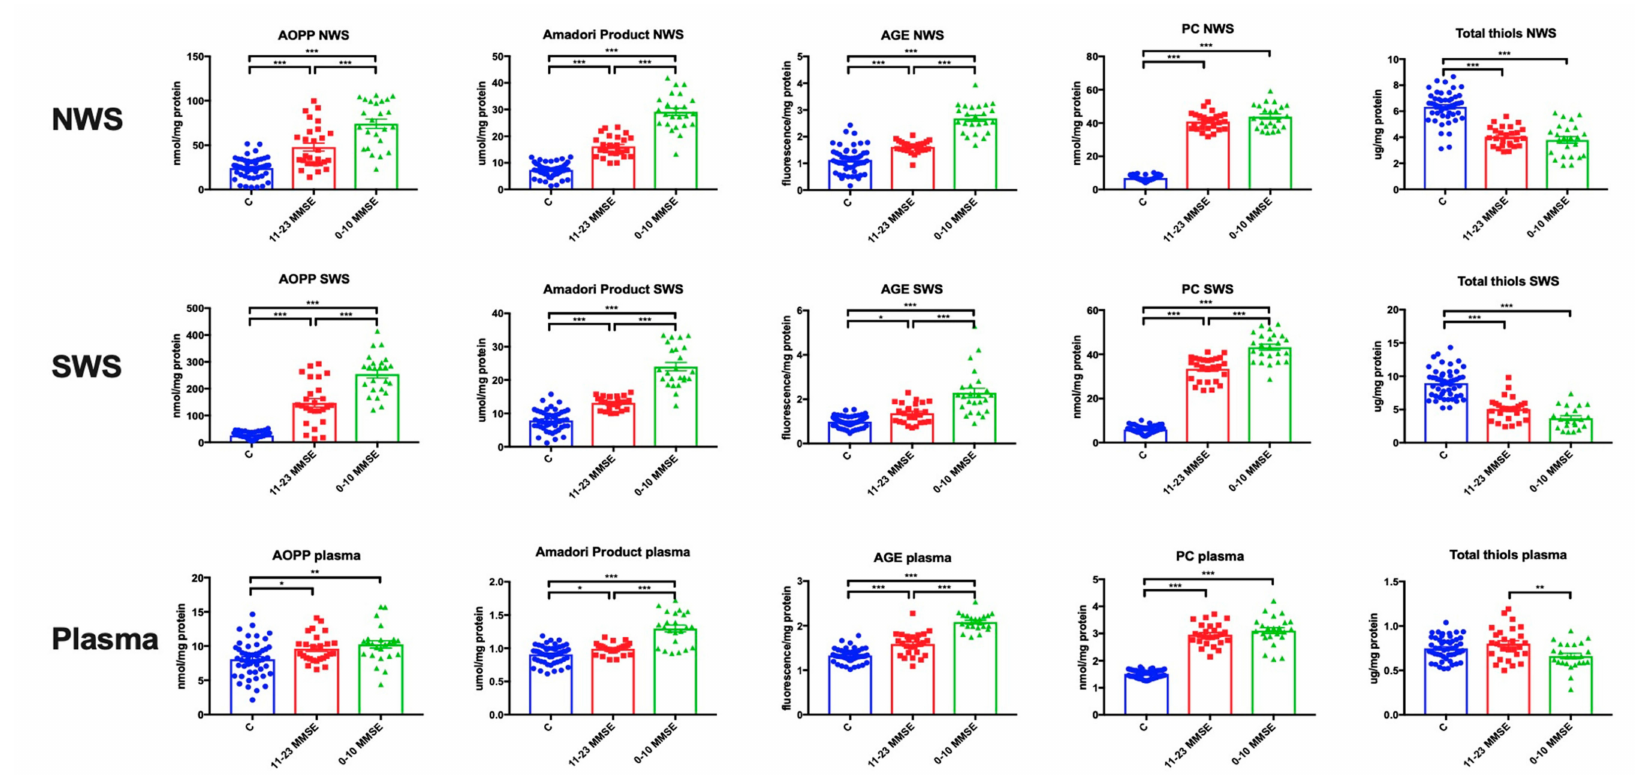
Figure 2. Oxidative damage in non-stimulated and stimulated saliva as well as plasma of patients in di ff erent stages of dementia, and healthy controls. Abbreviations: AGE—advanced glycation end products; AOPP—advanced oxidation protein products; C—the control; MMSE—Mini Mental State Examination; NWS—non-stimulated whole saliva; PC—protein carbonyls; SWS—stimulated whole saliva. * < 0.05, ** < 0.01, *** <